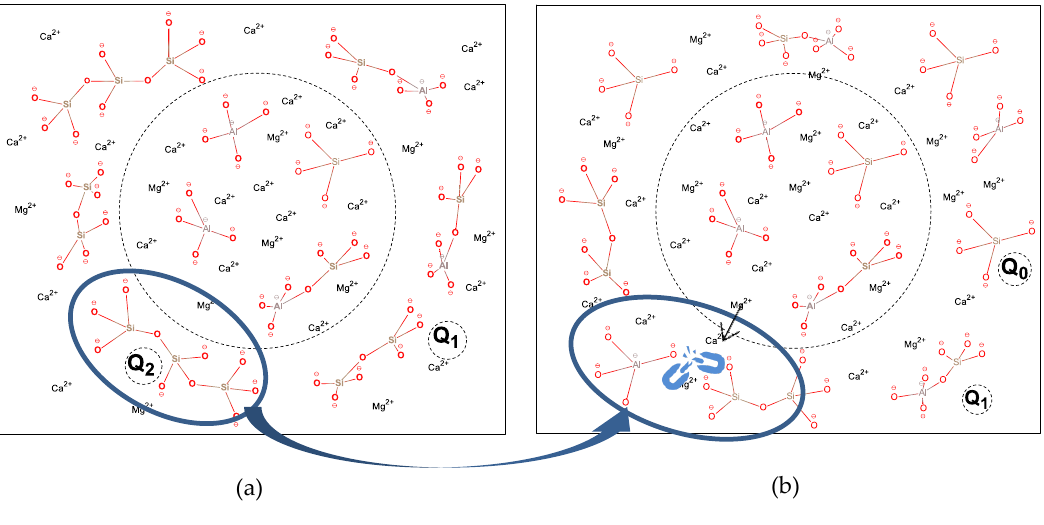
Figure 4. Schematic diagram of the e ff ect of S / A on the structure of amorphous networks: ( a ) slag with higher S / A; ( b ) slag with lower S / A. Note: This figure just serves as a schematic diagram with rarely a consideration of the real structure of a tetrahedron, the actual distribution state of a metal cation, and the charge balance.